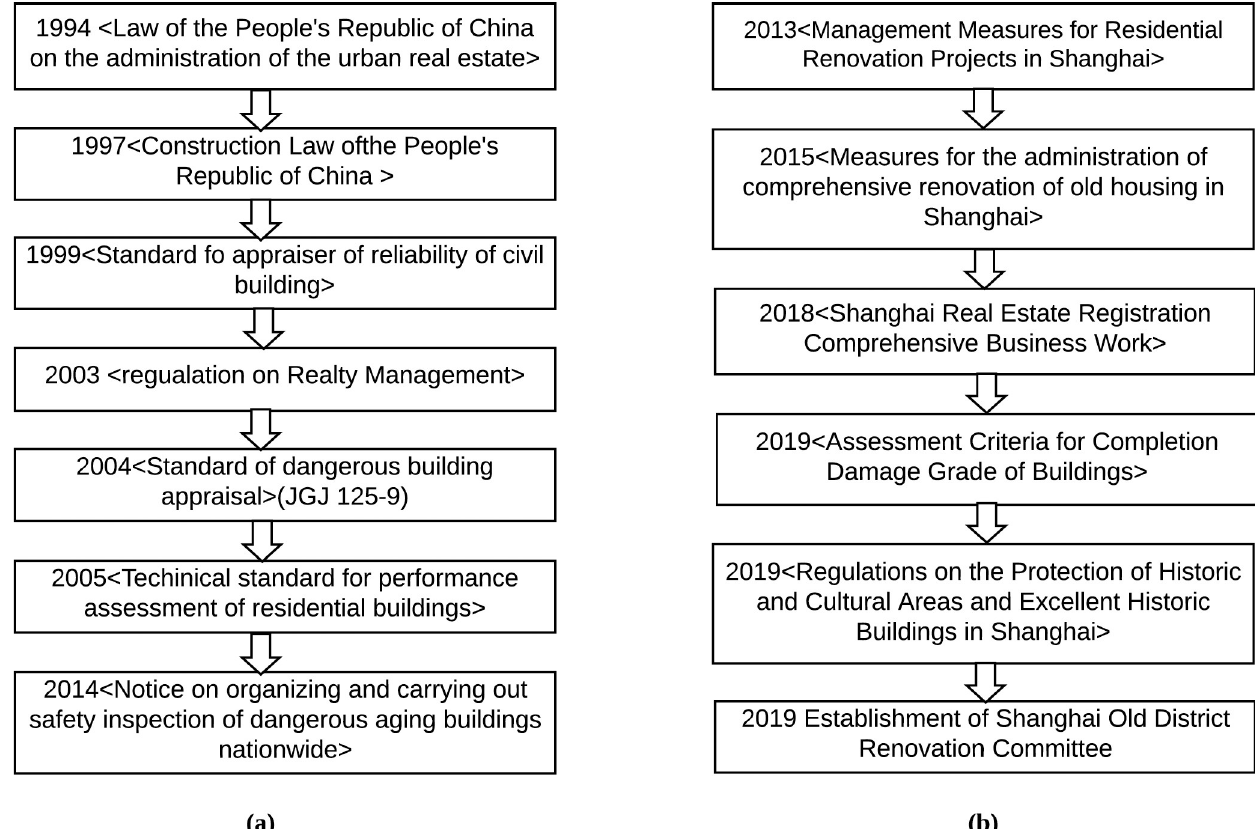
Fig 1. (a) Description of China’s housing security management progress. (b) Description of Shanghai’s housing security management progress.